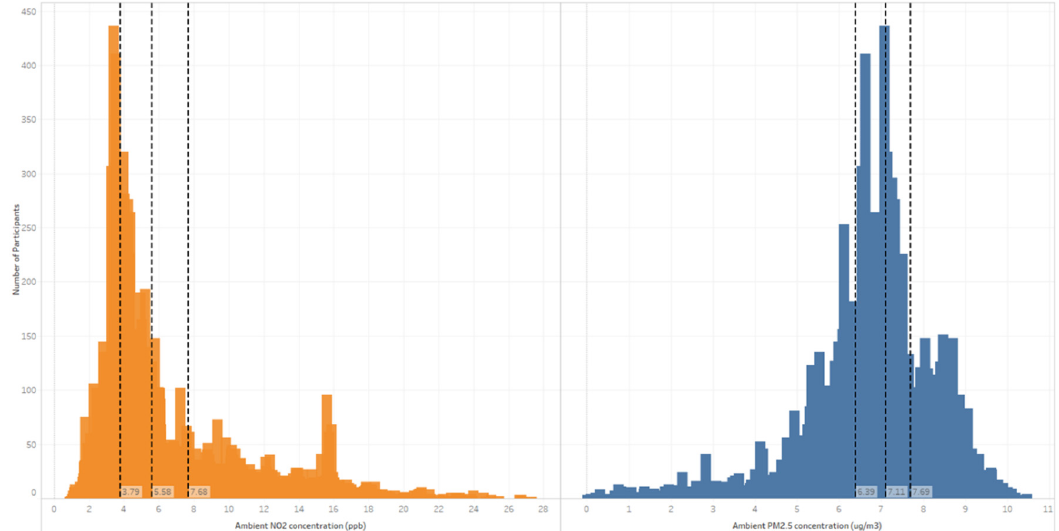
Figure 1. Ambient NO 2 (ppb) and PM 2.5 (ug/m 3 ) for the study population assigned to maternal residence at time of delivery.